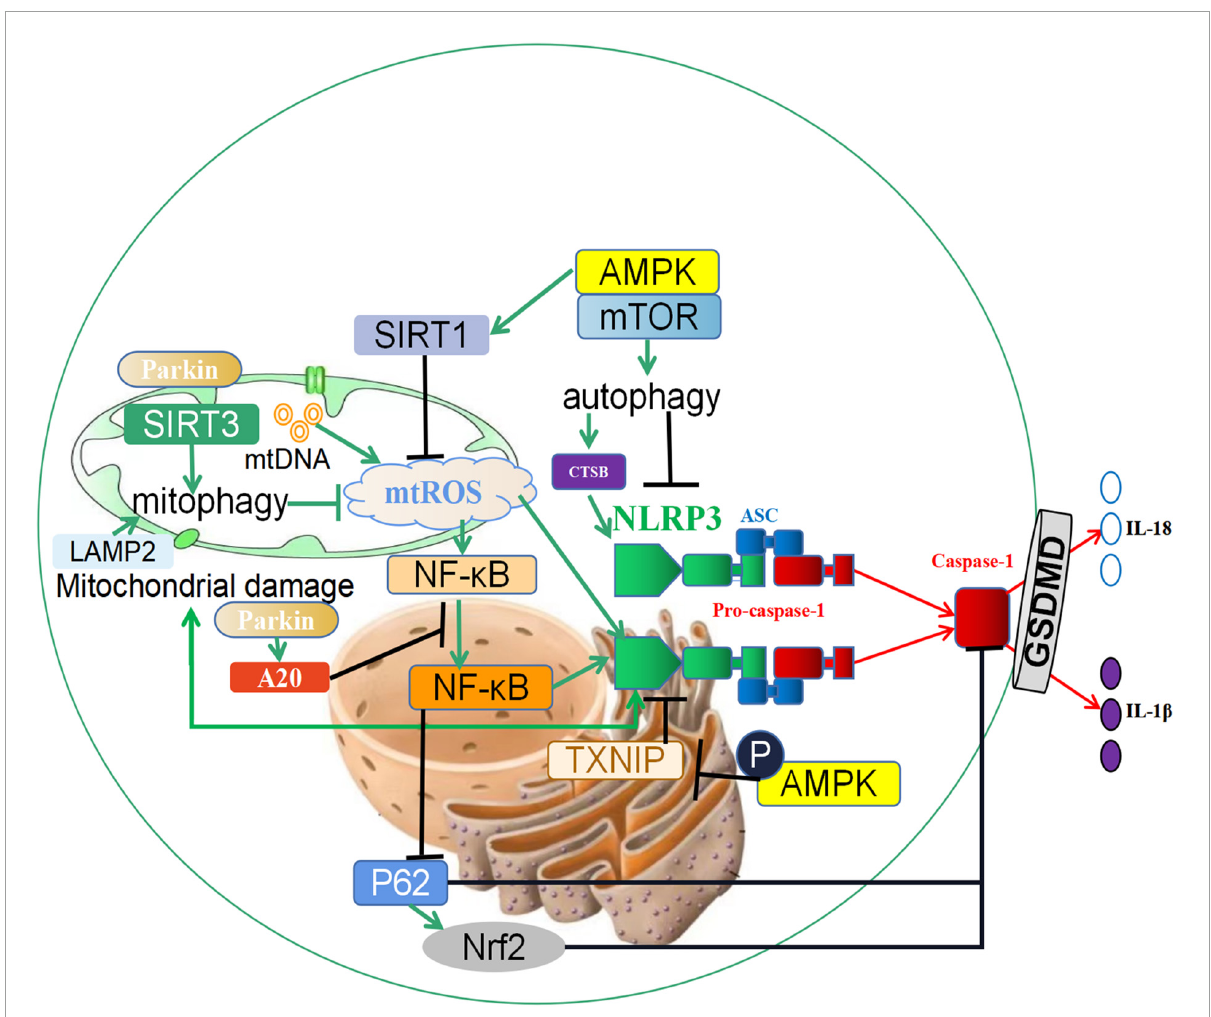
FIGURE2 The crosstalk between autophagy and pyroptosis. (1) SIRT3 induces the increase of mitophagy, inhibits the generation of reactive oxygen species (ROS) in mitochondria, and prevents the activation of inflammasome NLRP3. In addition, the expression changes of NLRP3 can reversely regulate mitochondrial damage and ROS generation; (2) Autophagy promotes the increase of CTSB, accelerates the activation of the NLRP3 inflammasome, and induces the occurrence of pyroptosis; (3) Parkin promotes the occurrence of mitophagy, and it also increases the expression of A20, which inhibits the nuclear entry and activation of NF- κ B, and reduces the activity of the NLRP3 inflammasome. In addition, NF- κ B can also promote the activation of Caspase-1 through the p62 and Nrf2/ARE axis and accelerate the occurrence of pyroptosis. (4) Phosphorylation of the autophagy-related protein AMPK leads to the degeneration of TXNIP and promotes the activation of the NLRP3 inflammasome. Furthermore, the AMPK/mTOR pathway promotes the expression of SIRT1, downregulates reactive oxygen species, and prevents the activation of the NLRP3 Inflammasome. ↑ induce; ⊥